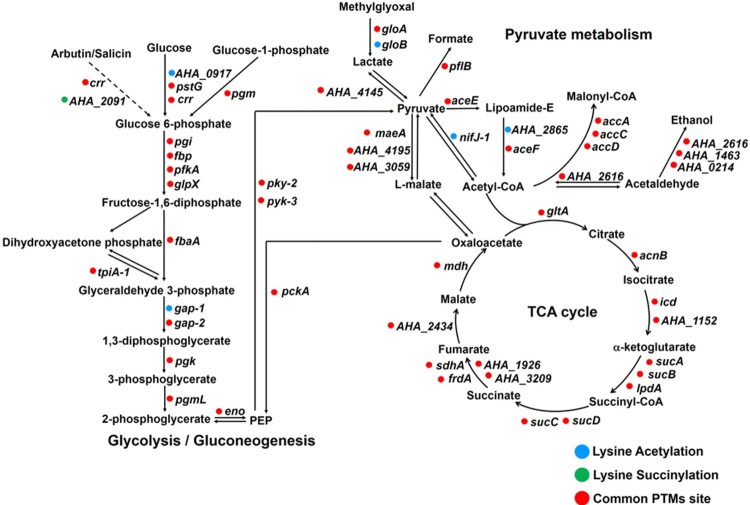
Schematic representation of lysine acetylation and succinylation in glycolysis/gluconeogenesis, TCA cycle, and pyruvate metabolism. The circle colour represents acetylation (blue), succinylation (green), or common PTMs sites (red), respectively.